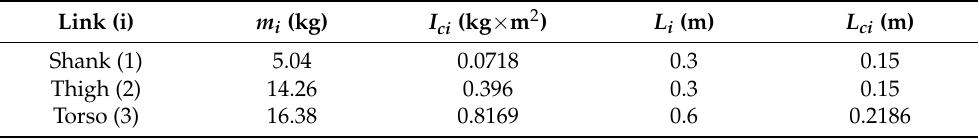
Table 1. Inertial robot parameters used in the